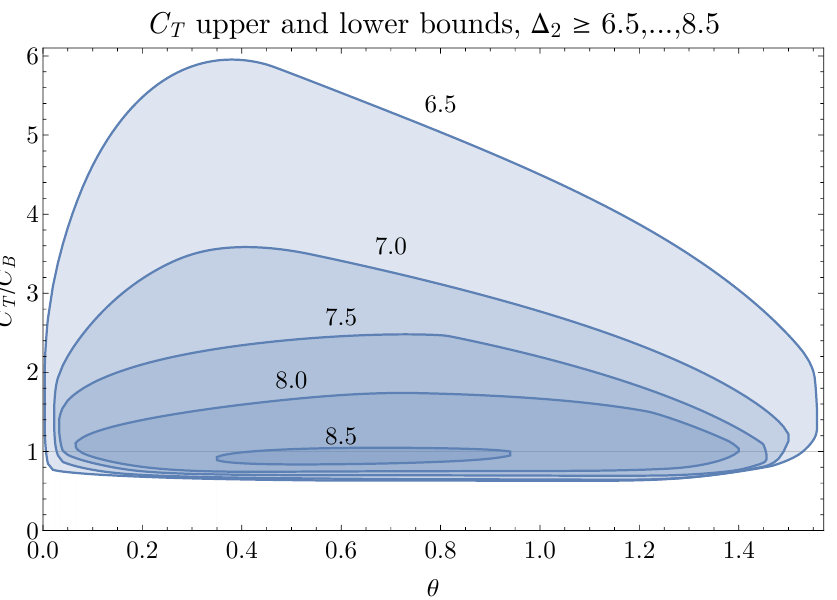
Figure 11 . Upper and lower bounds on C T as a function of (cid:18) in 3d CFTs for di(cid:11)erent gaps between the stress tensor and the second parity-even spin-2